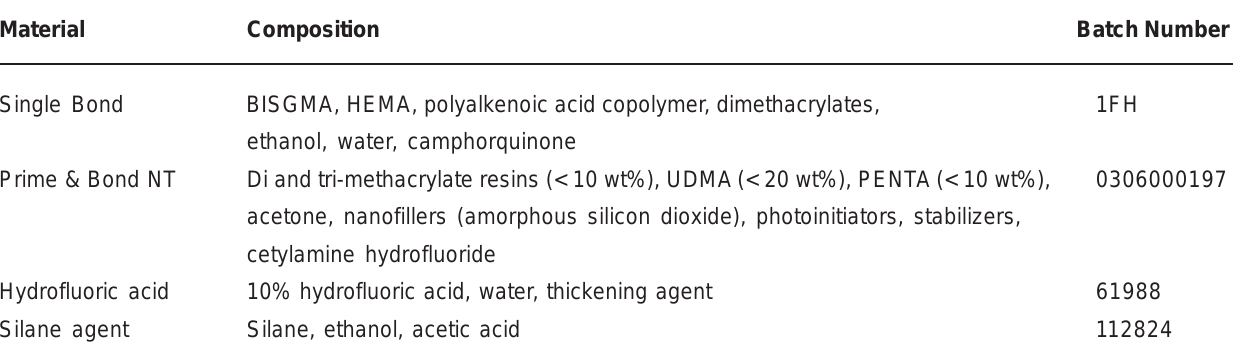
TABLE 1- Materials used in the study and their respective compositions and batch numbers